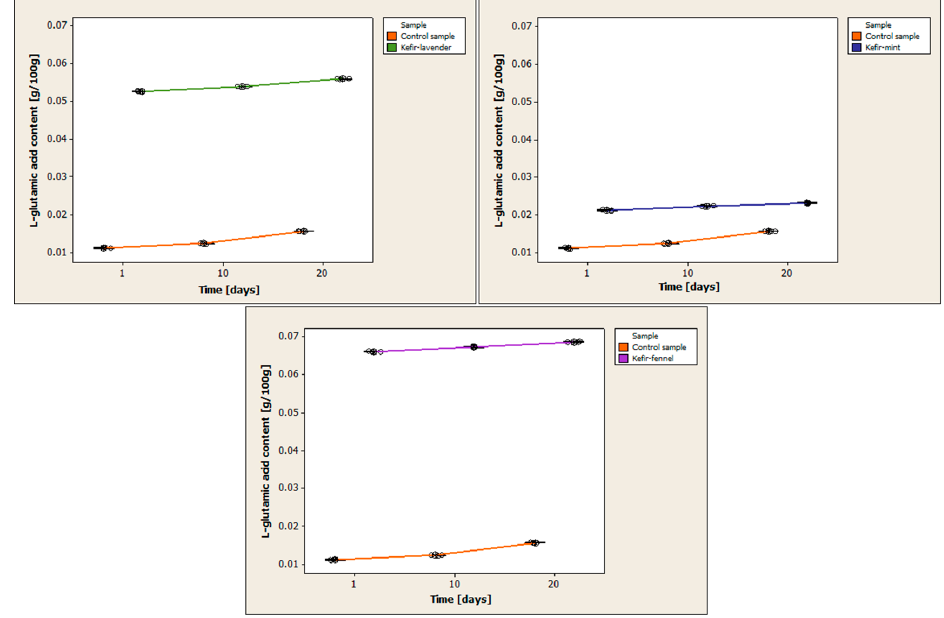
Figure 6. Comparative variation of L-glutamic acid content determined by the enzymatic method in kefir samples with encapsulated volatile oils and the control sample.